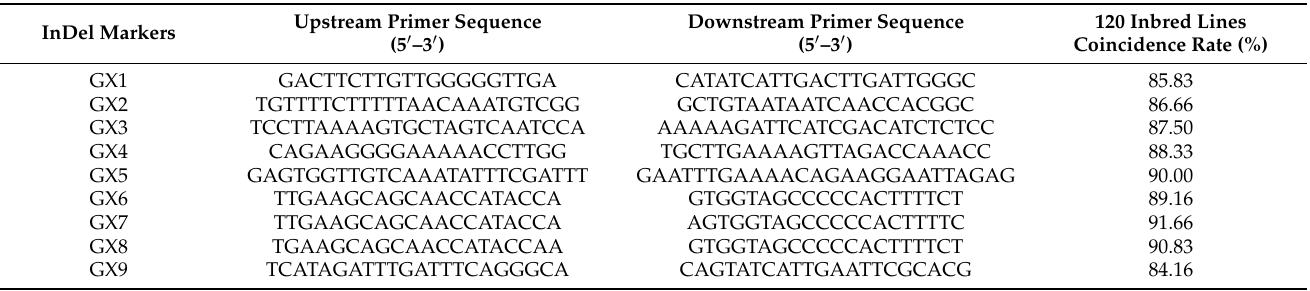
Table 1. Coincidence rate of nine pairs of fruit-shape InDel markers in 120 inbred lines. InDel